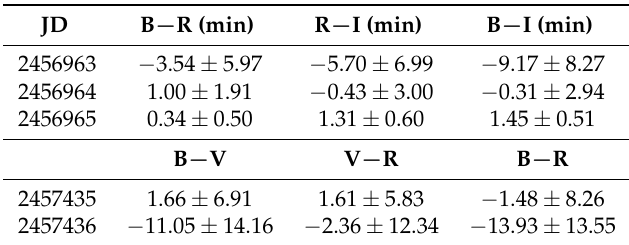
Table 2. Results of inter-band time